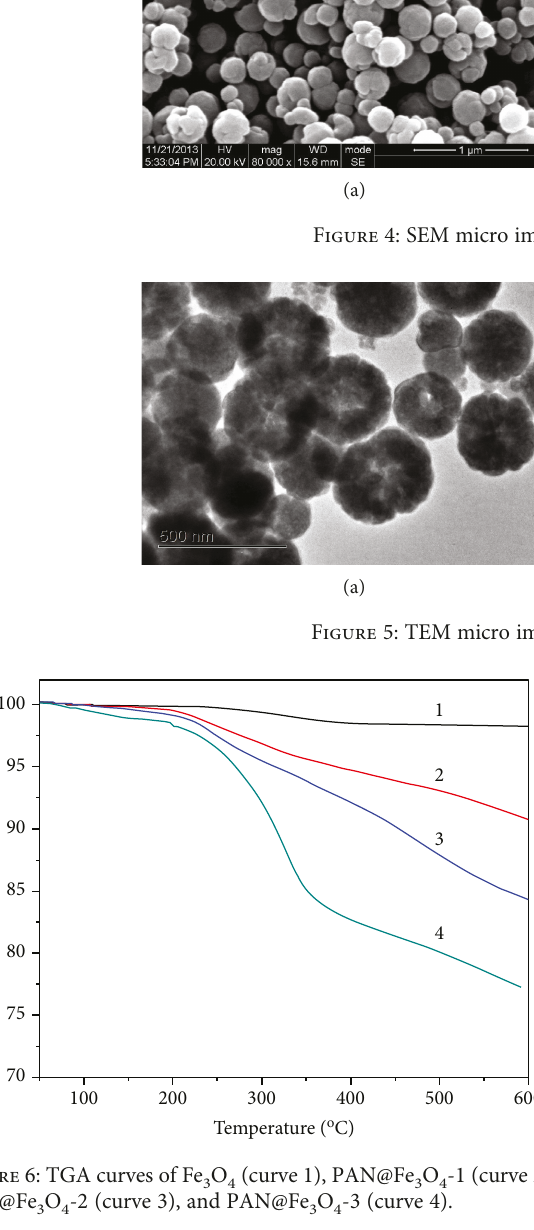
O -2 (curve 3), and PAN@Fe 3 4